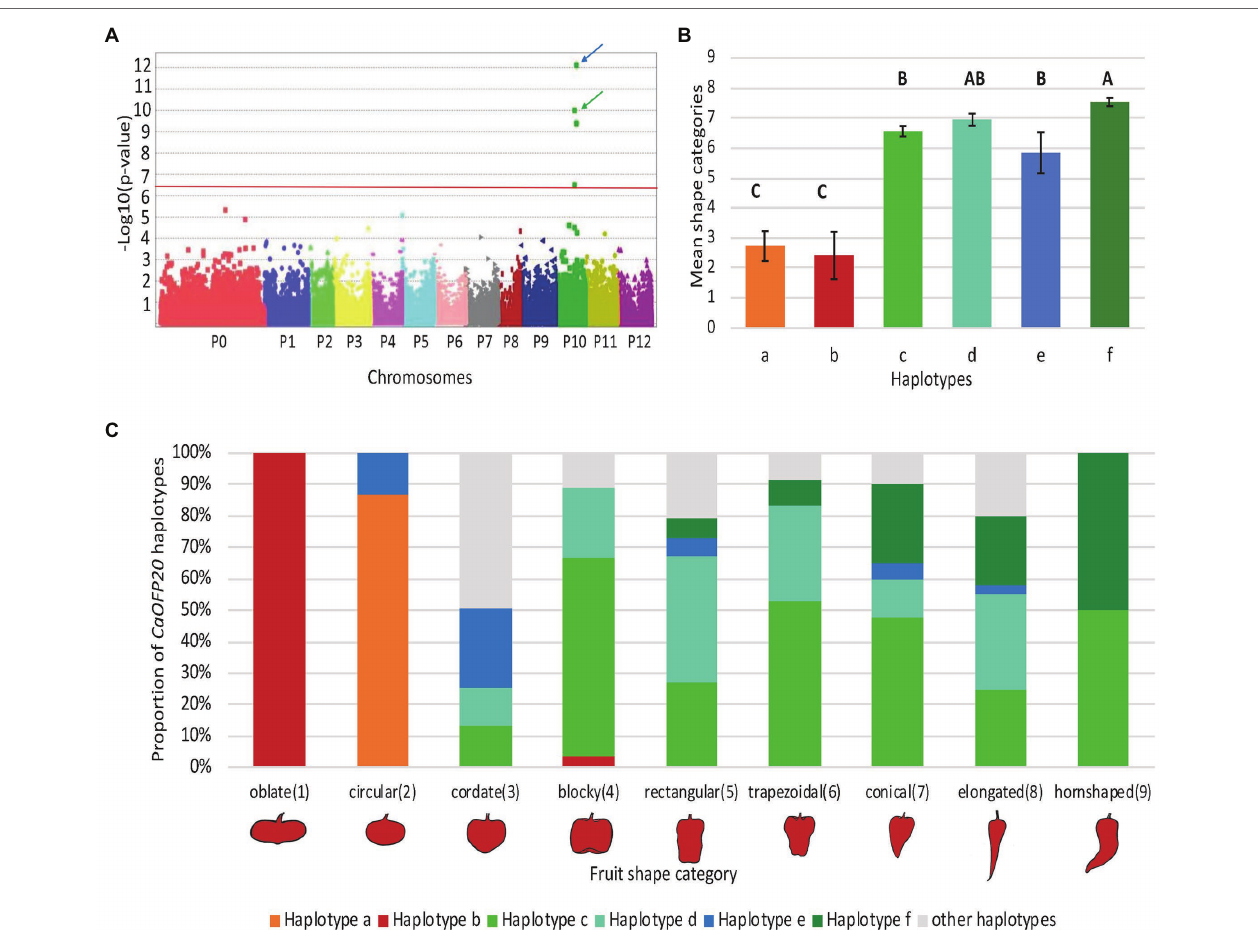
FIGURE 8 | GWAS plot and haplotypes based on allelic variation at CaOFP20 and their association with fruit shape categories in the association panel. (A) GWAS plot for fruit shape categories in the association panel. Blue arrow indicates the SNP at position 142898783 bp, downstream of CaOFP20 ; green arrow indicates the most significant marker at the CaOFP20 locus at 130121672 bp. Red line represents the FDR-derived genome-wide significance threshold. P0 – SNPs that were not assigned to chromosomes. (B) Means of fruit shape categories of the different haplotypes. The six haplotypes in the association panel had at least five accessions per haplotype. Differences among means were determined by Tukey–Kramer range test at p < 0.05 and are indicated by different uppercase letters. (C) Haplotype composition of fruit shape